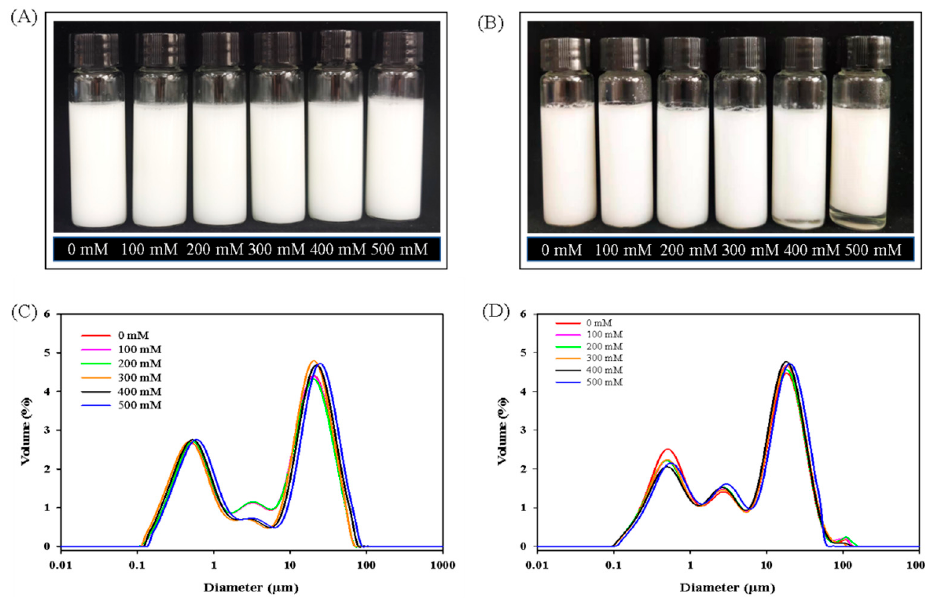
Figure 2. Effects of NaCl concentration on the appearance ( A , B ) and particle size distribution ( C , D ) of filled hydrogels at stored for 0 days ( A , C ) for 10 days ( B , D ). Table 1. Effects of sodium chloride (NaCl) concentration on droplet size of filled hydrogels during storage. Sodium Chloride (NaCl,